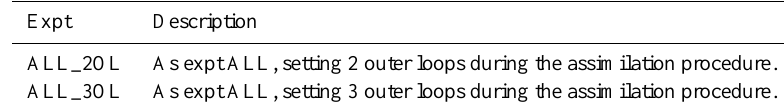
Table 3. Description of the experiments performed using 3DVAR with multiple outer loops. Expt Description ALL_2OL As expt ALL, setting 2 outer loops during the assimilation procedure. ALL_3OL As expt ALL, setting 3 outer loops during the assimilation